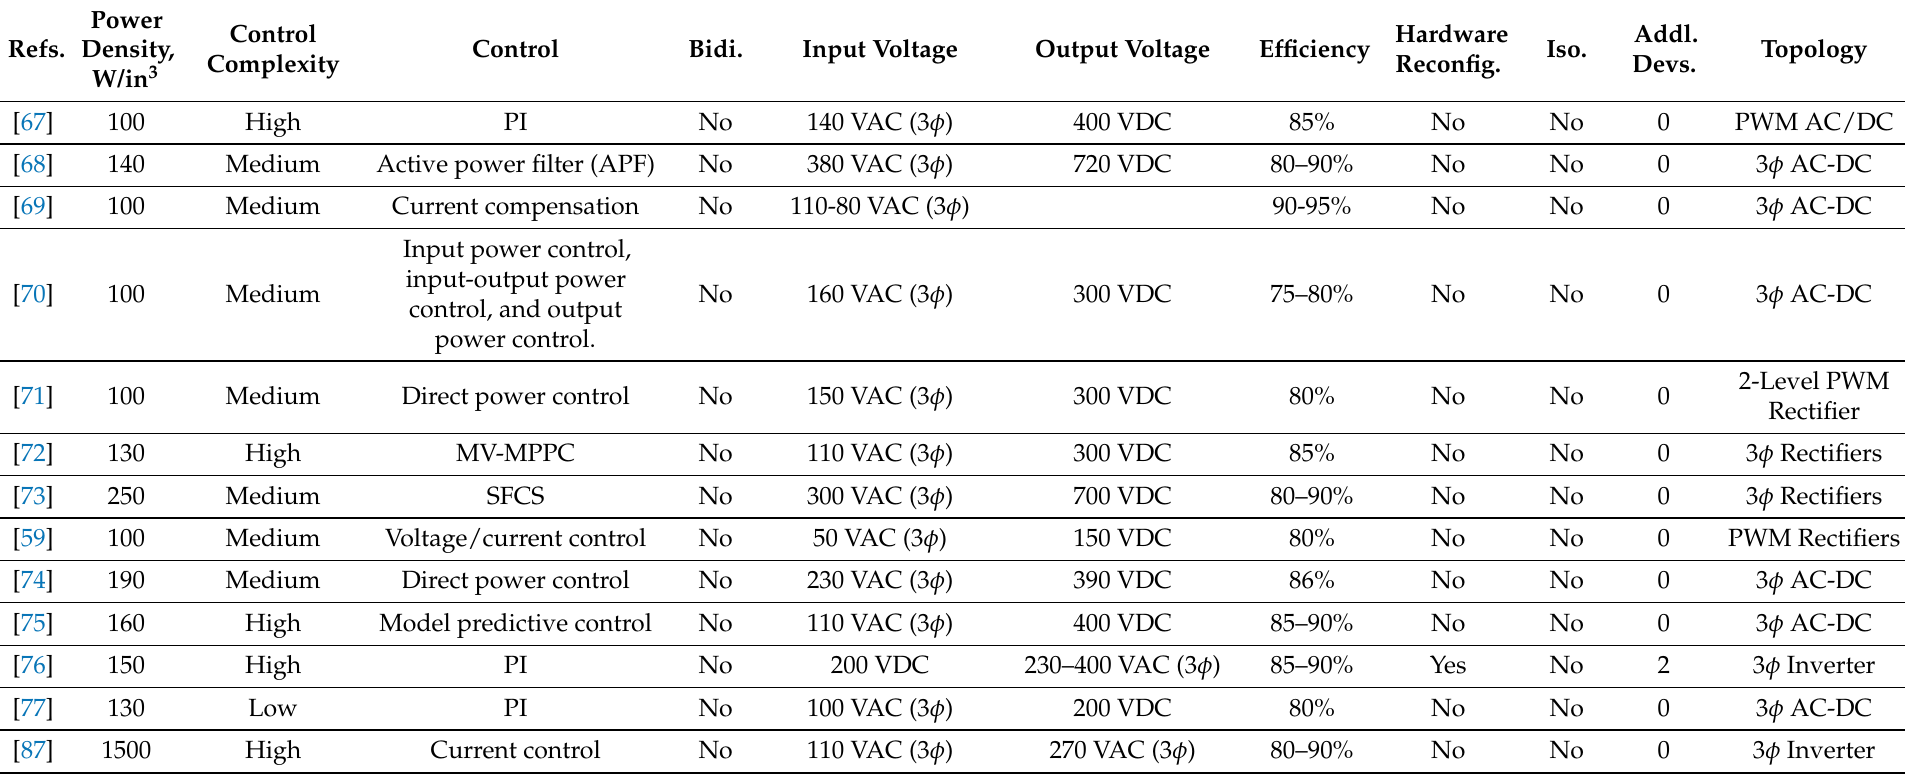
Table 6. Comparison of the different fault-tolerant network-level